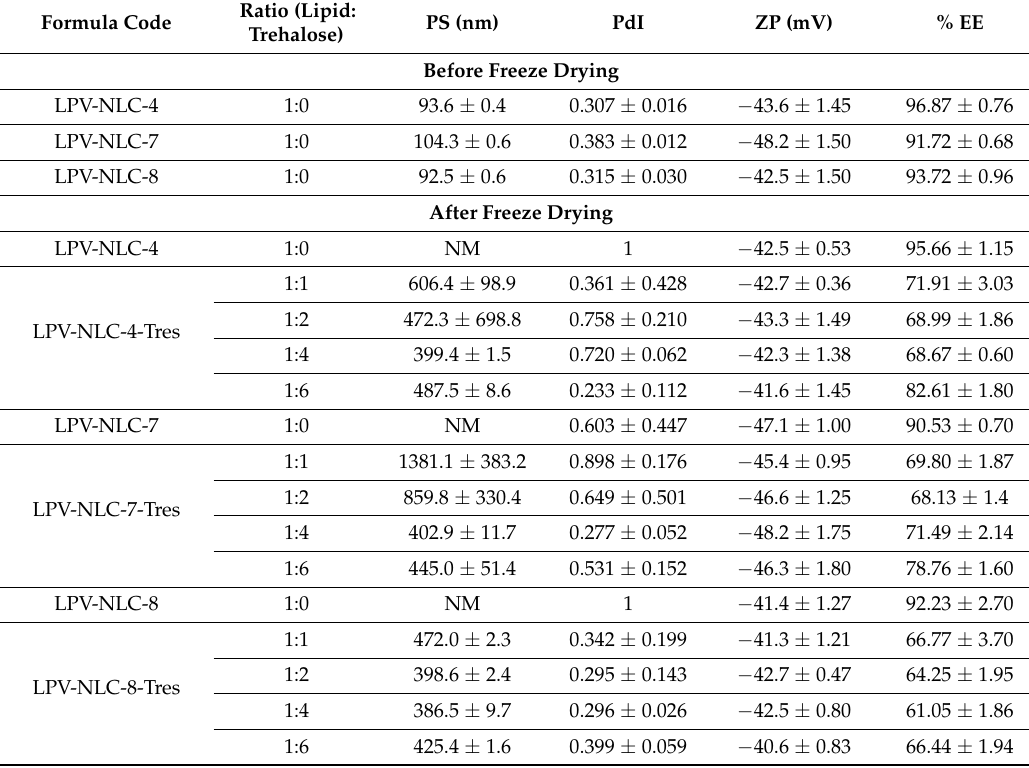
Table 5. Influence of cryoprotectant addition after homogenization process on PS, PdI, ZP and %EE.